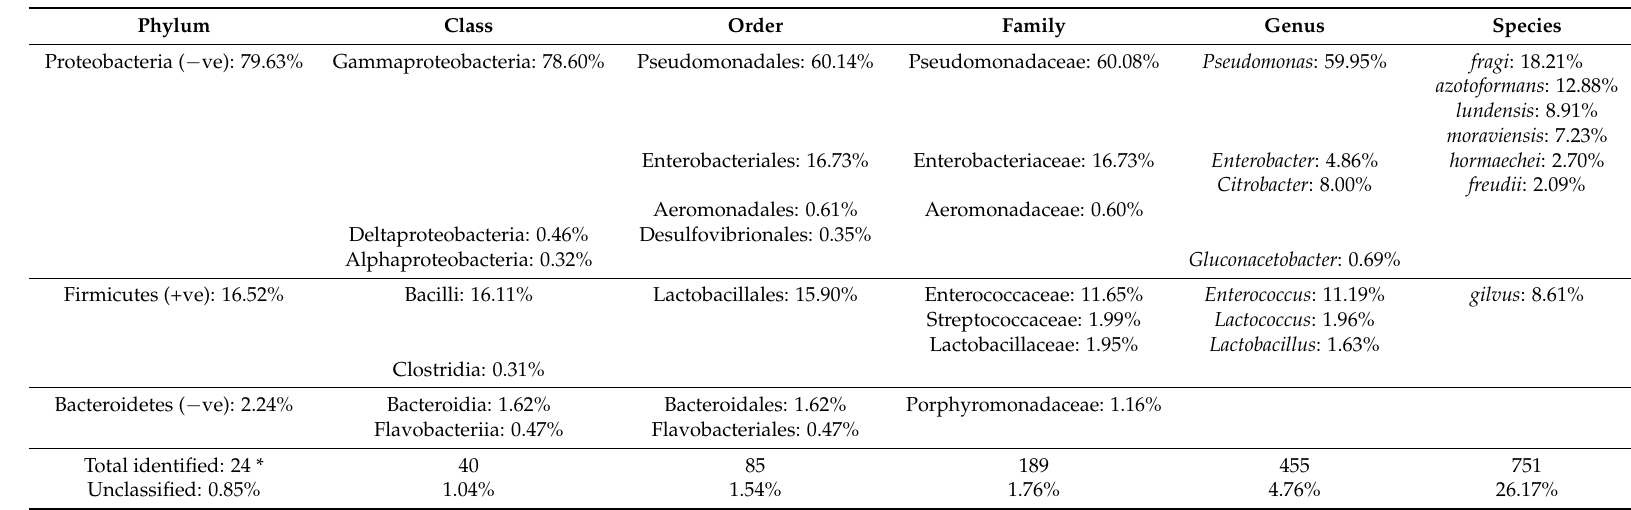
Table 3. Bacterial community (Top 7 identifications) in the whole body extract of P.